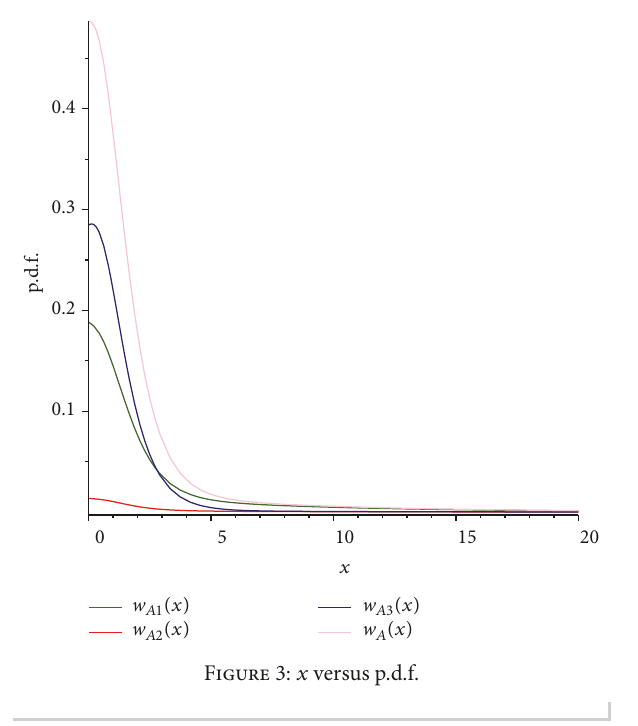
Figure 3: 𝑥 versus